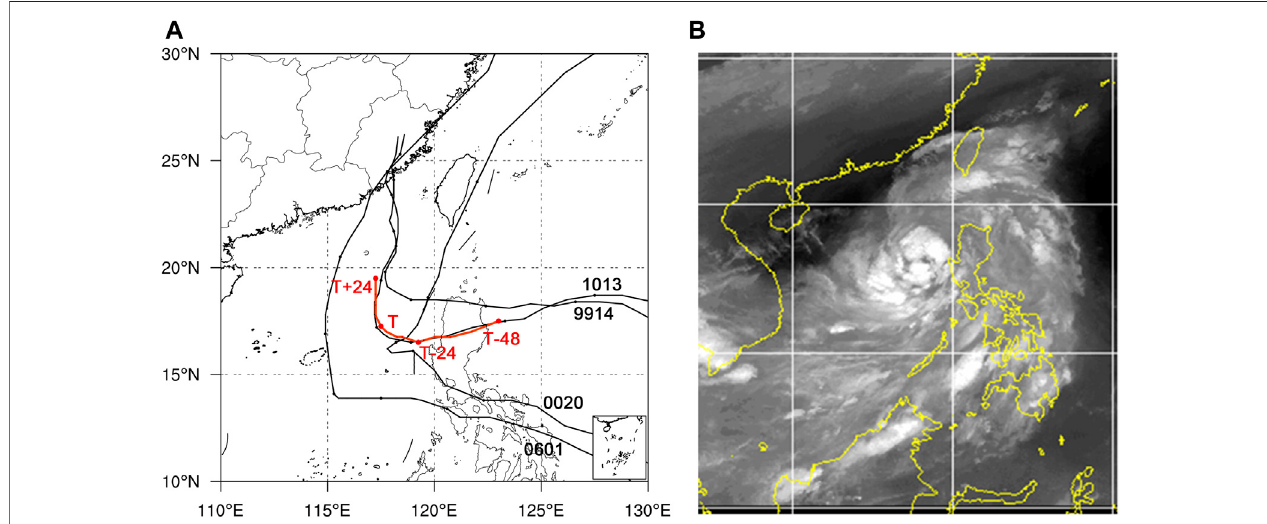
FIGURE 1 | (A) The four north turning typhoon cases in the study (black) and their composited track (red) (Numbers are the typhoon number of the TC; T means turningtime,negative/positive means pre-recurving/post-recurving time.) and (B) TheCIMMSwater vapor satellite image oftyphoon Xangsane (2000) at 12:00 Oct. 29,